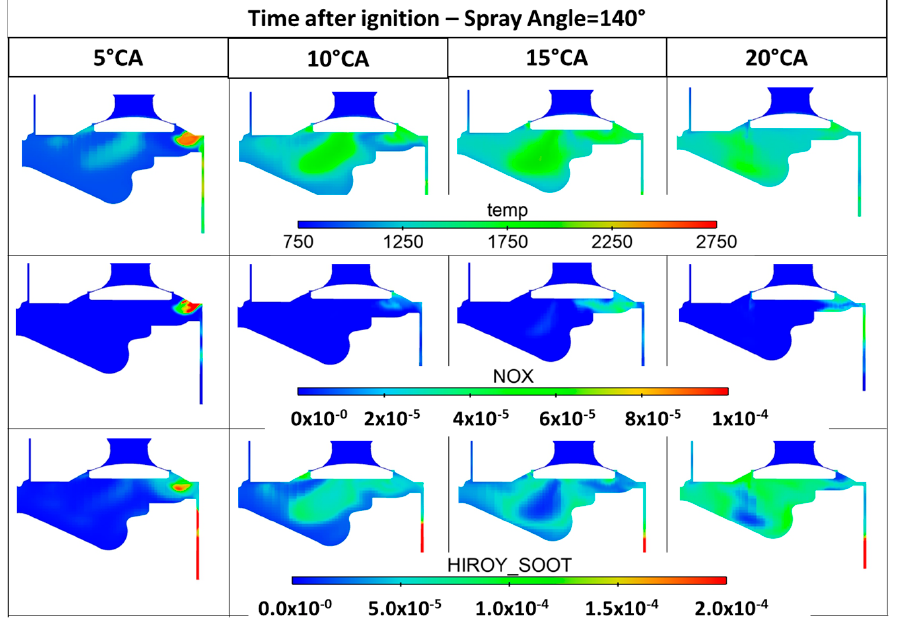
Figures 34–38, respectively.